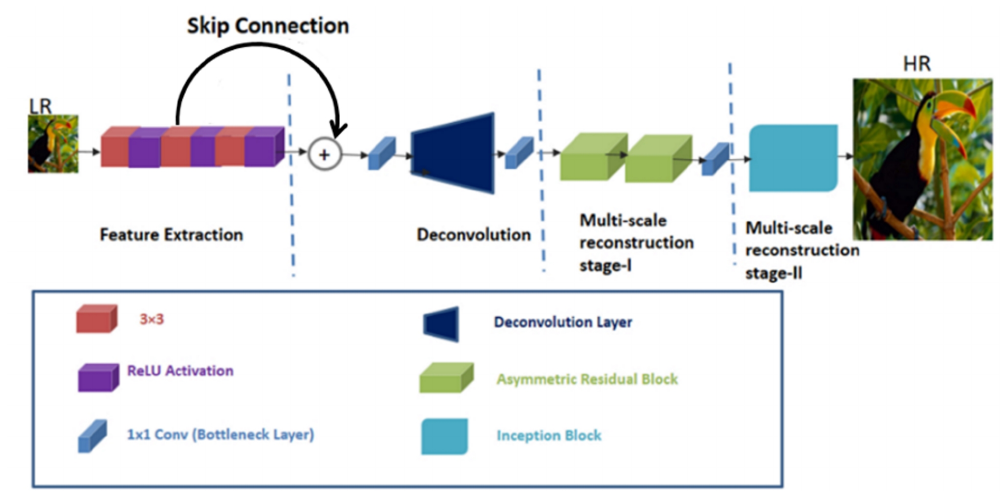
Figure 1. The complete network architecture of our proposed super-resolution (SR) method. Our network consists of feature extraction, deconvolution, multi-scale reconstruction stage-I, and multi-scale reconstruction stage-II. LR = low-resolution; HR = high-resolution; ReLU = rectified linear unit; Conv =